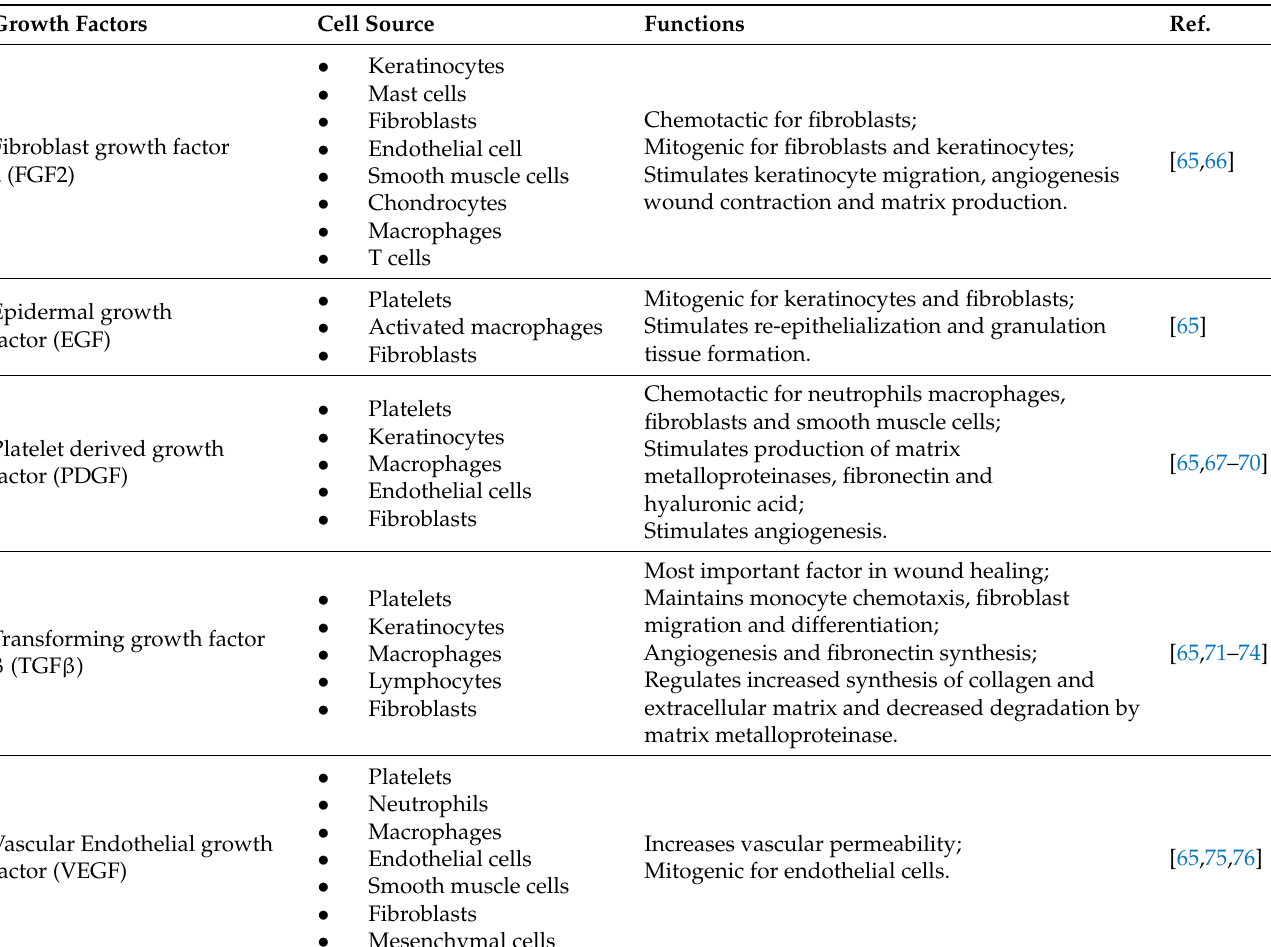
Table 1. A compilation of the essential growth factors, their cell source and functions during the wound healing